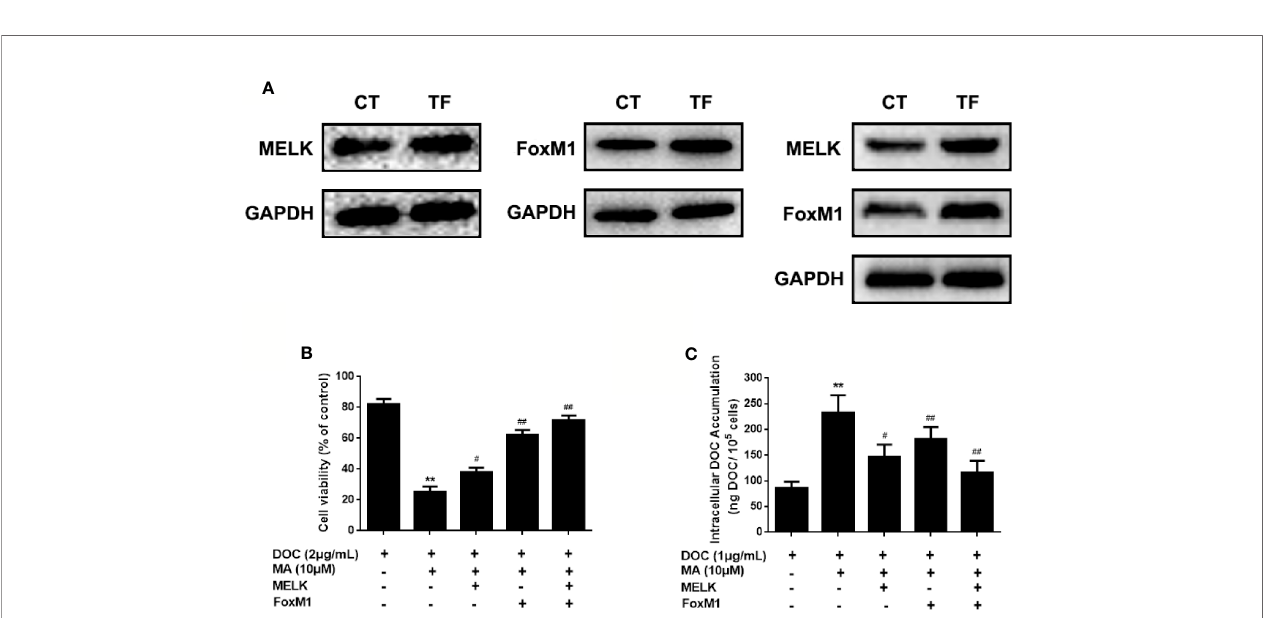
FIGURE 5 | The contribution of MELK-FoxM1 signaling to the potentiated effect of maslinic acid (MA) on cellular docetaxel (DOC) accumulation in MDA-MB-231/ DOC cells. MDA-MB-231/DOC cells transfected with maternal embryonic leucine-zipper kinase (MELK) alone, FoxM1 alone or MELK+FoxM1 were treated with DOC alone or DOC combine d MA for 24 h. (A) The expressions of MELK and FoxM1 in cells with MELK or FoxM1 transfection alone and MELK and FoxM1 co- transfection were assessed by western blot analysis. (B) Cell viability was assessed by MTT assay. (C) Cellular DOC accumulation was evaluated by high performance liquid chromatography (HPLC) analysis. ** p < 0.01 vs. treatment of DOC alone, # p < 0.05, ## p < 0.01 vs. co-treatment of DOC and MA. All data were presented as means ± SD with three independent experiments, and triplicate repeats were included in each experiment. CT, control; TF,